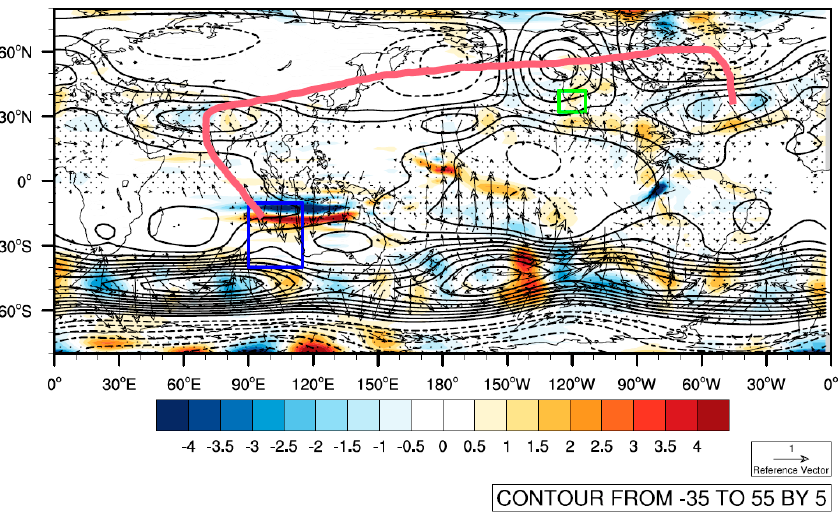
Figure 7. Geopotential height (contour; gpm), wave activity (vector; m/s), and wave activity flux (shading; s − 1 ) at 200 hPa (bottom) in winter regressed to the box-averaged SST (blue box). The red line highlights the wave train. The green box represents the selected California area. Only the wave activity exceeding the 90% confidence level is shown. Areas with dots exceed the 90% confidence level.